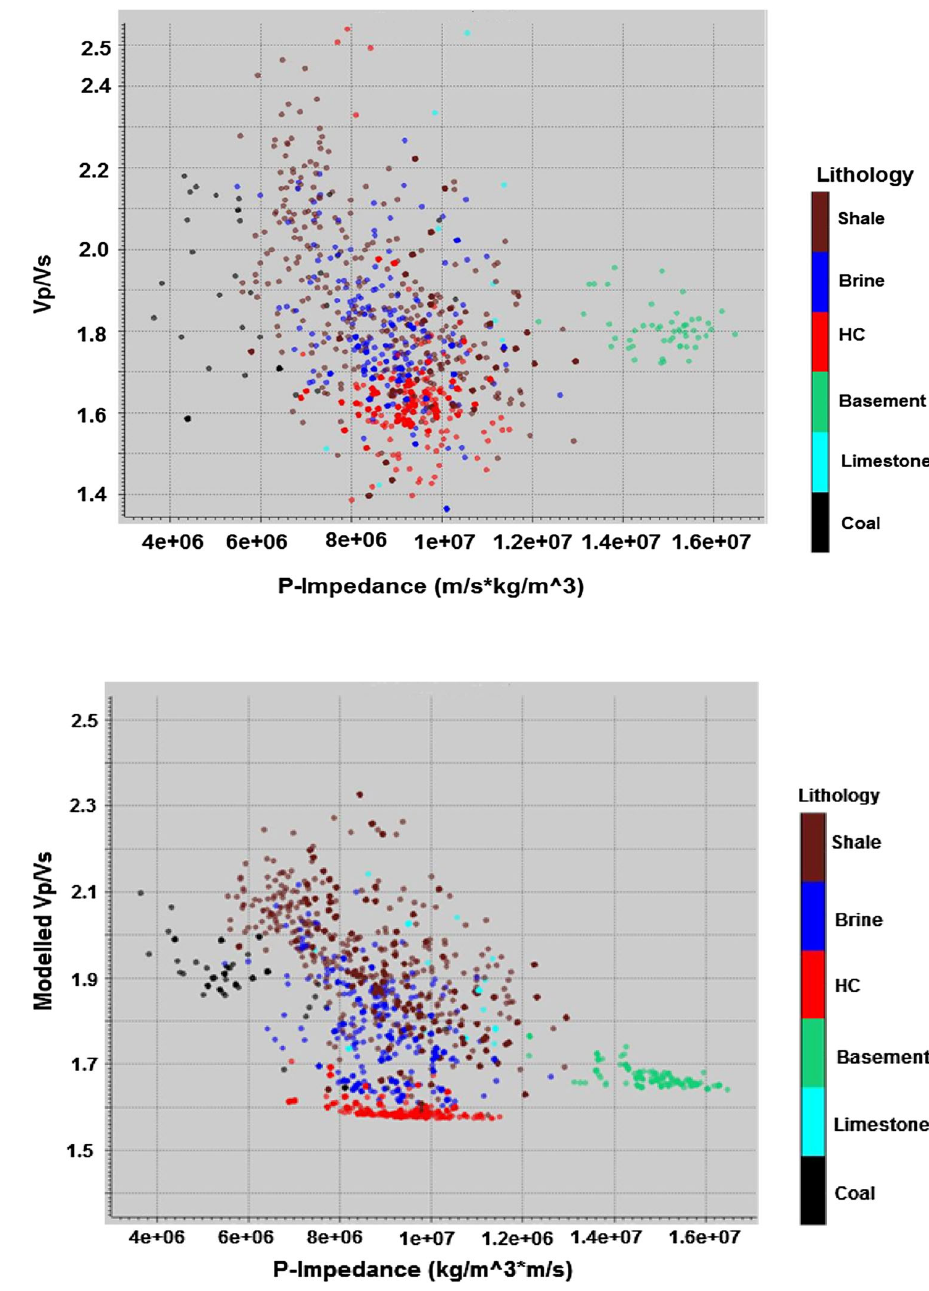
versus modeled V P / V S cross- plots for all wells colored by